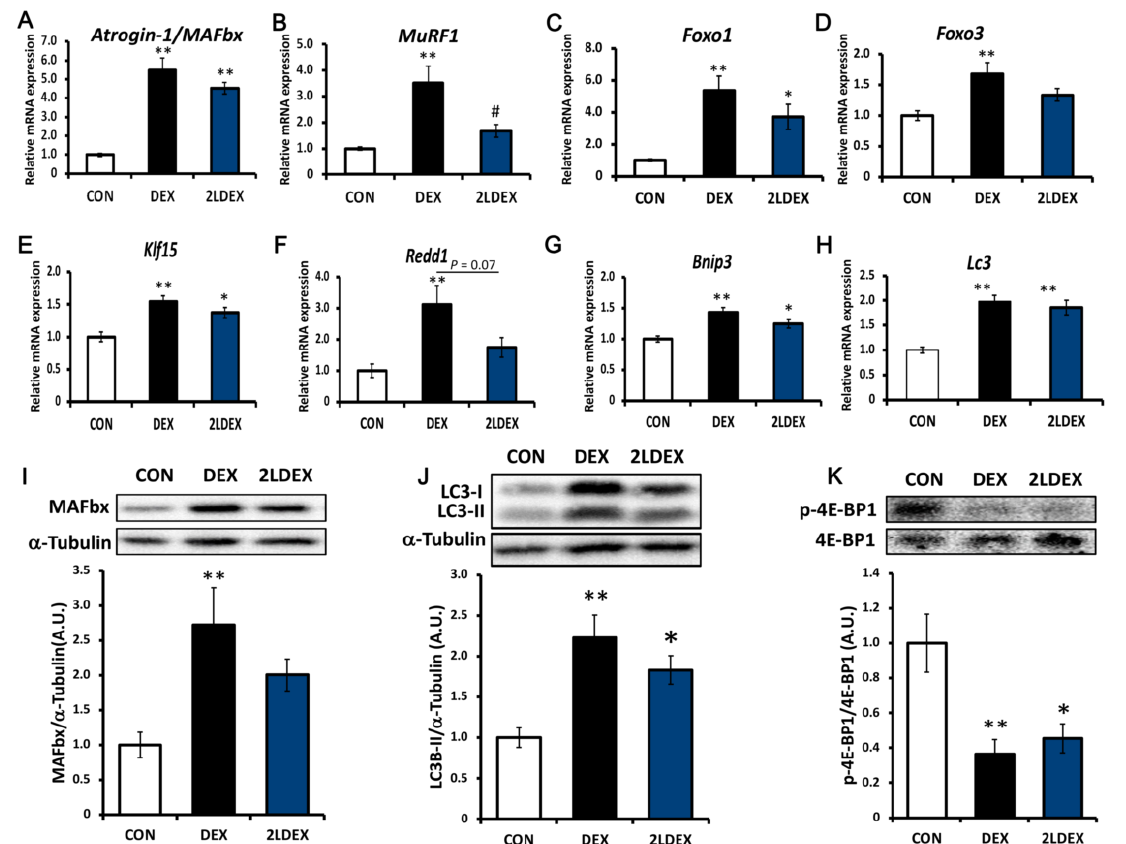
Figure 5. Effects of laurel on key regulatory checkpoints of the ubiquitin-proteasome system, the autophagolysosome system, and the mTOR signaling pathway in rat gastrocnemius muscle atrophy. mRNA levels of ( A ) atrogin-1/MAFbx, ( B ) MuRF1, ( C ) Foxo1, ( D ) Foxo3, ( E ) Kif15, ( F ) Redd1, ( G ) Bnip3, and ( H ) Lc3. Western blot analysis of ( I ) atrogin-1/MAFbx, ( J ) LC3, and ( K ) p-4E-BP1/4E- BP1 expression; for densitometric analysis, the band intensity of the respective protein was normalized to that of α -tubulin. Data are shown as the mean ± SE ( n = 7). Statistical significance was evaluated by Tukey’s test. * p < 0.05, ** p < 0.01 vs. control group. # p < 0.05 vs. DEX